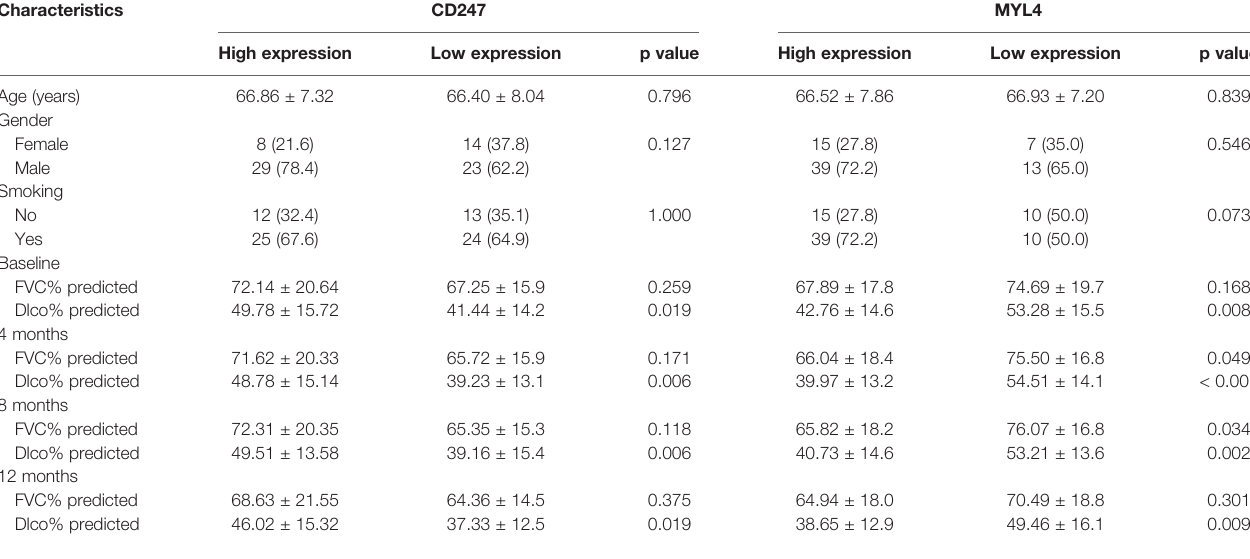
TABLE 4 | Baseline characteristics of the patients among different groups in the GSE132607 dataset.